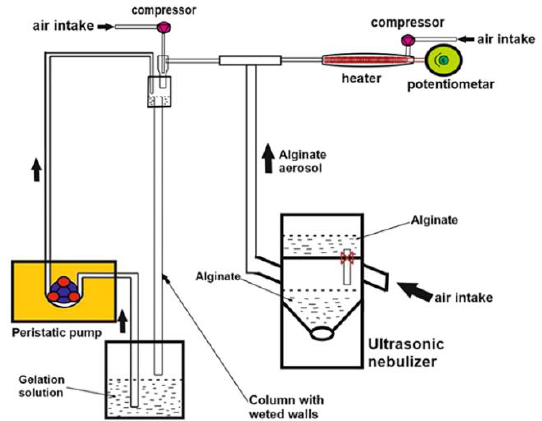
Figure 7. Scheme of the apparatus for the preparation of calcium alginate submicrobeads by utrasonic spray atomization method.